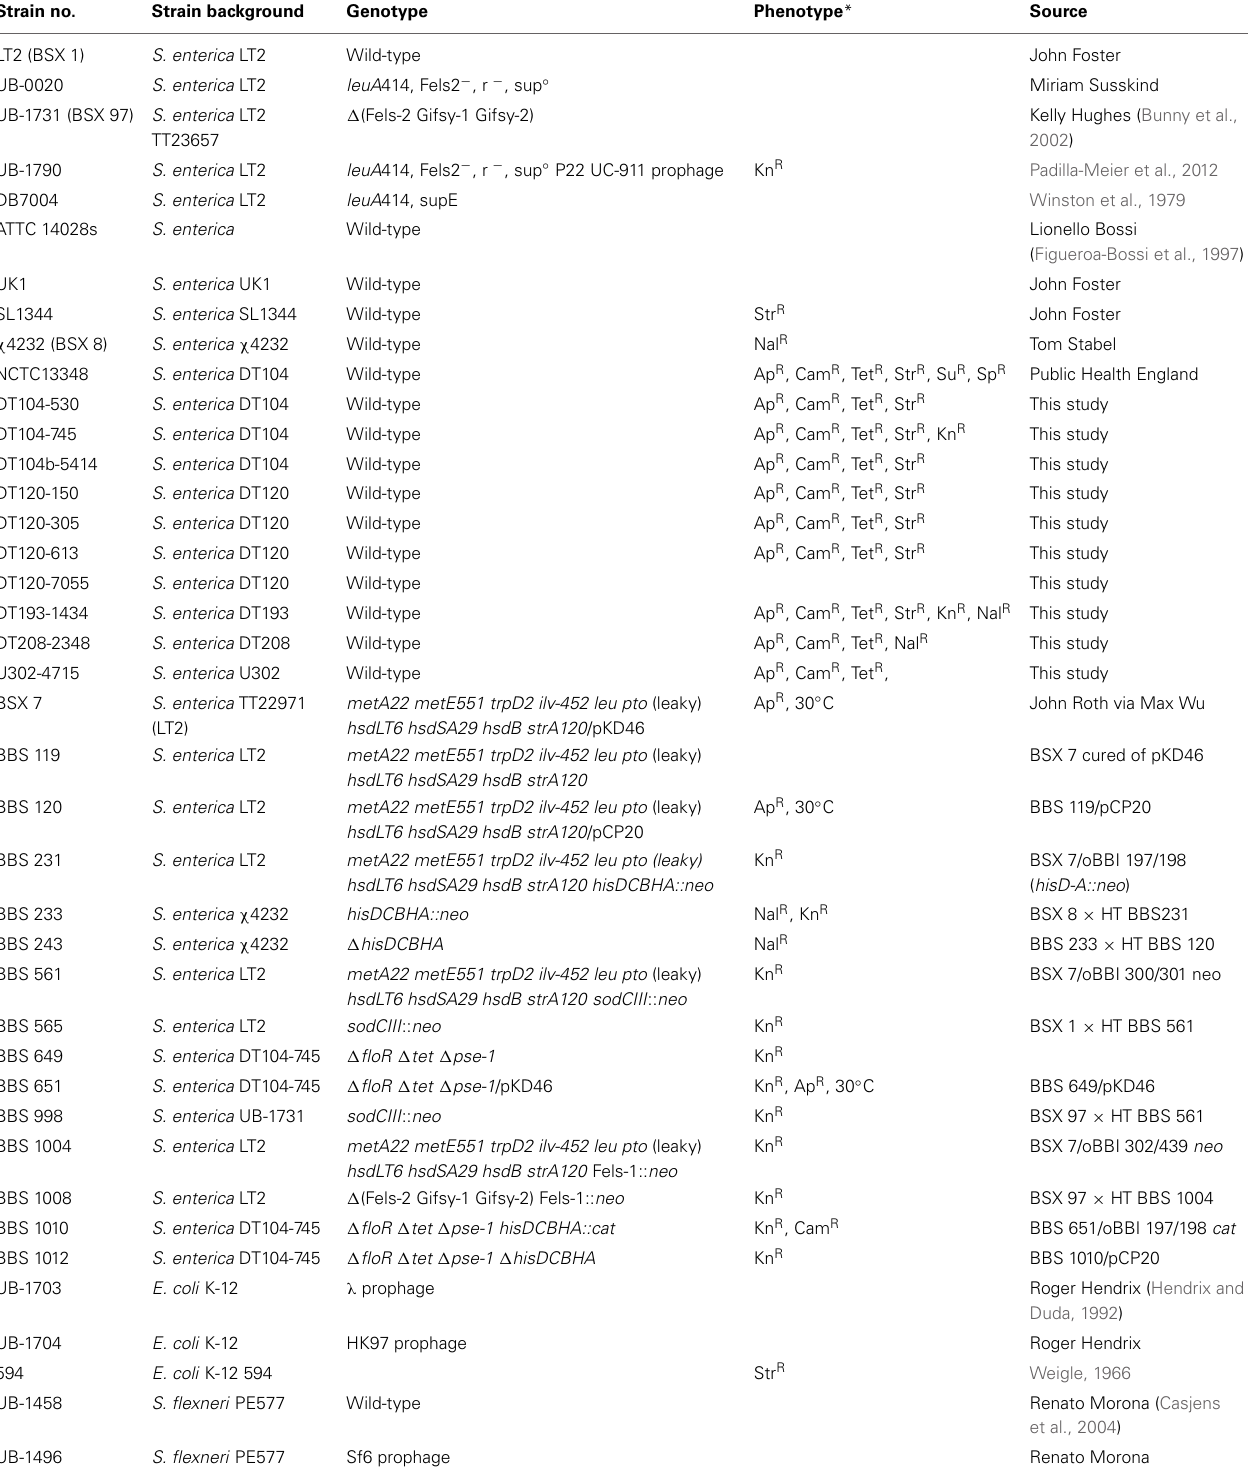
Table 1 | Bacterial strain list. Strain